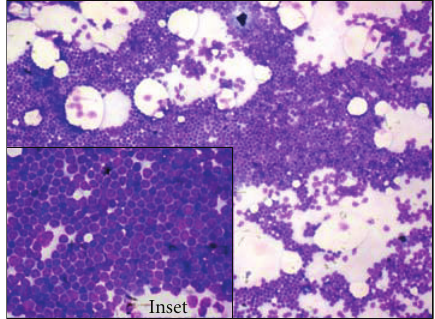
Figure 4: Peripheral blood film shows predominantly lympho- cytosis, few smudge cells ( red arrow ), and occasional hyperseg- mented neutrophils ( black arrow ) suggestive of chronic lymphocytic leukemia.